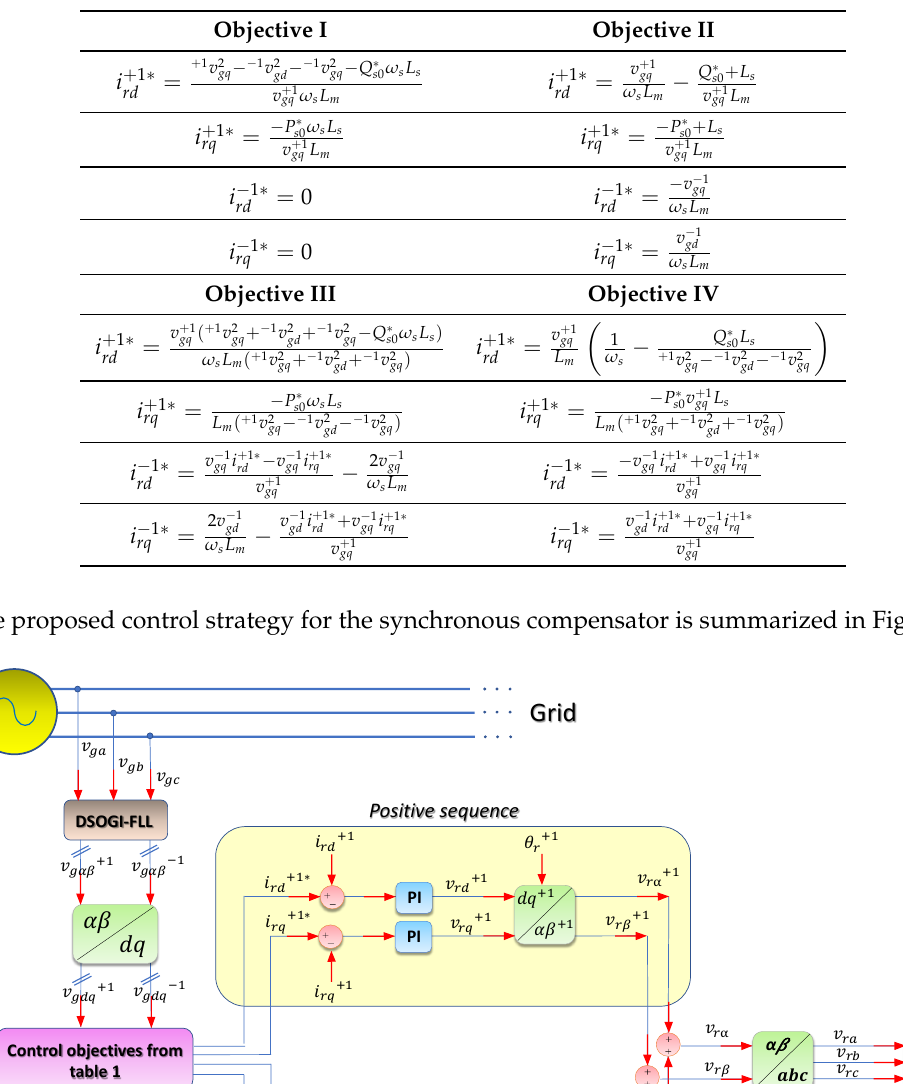
Table 1. Calculation of rotor reference currents for the four objectives studied.